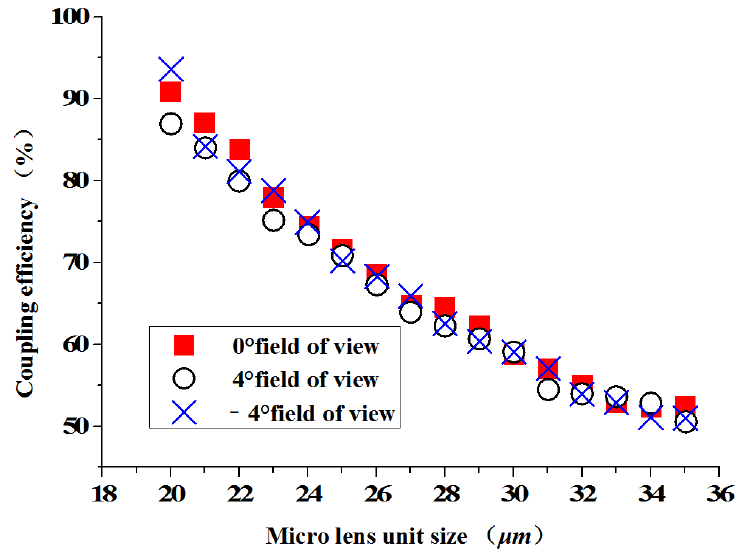
Figure 6. The size of the micro lens unit and the coupling efficiency.